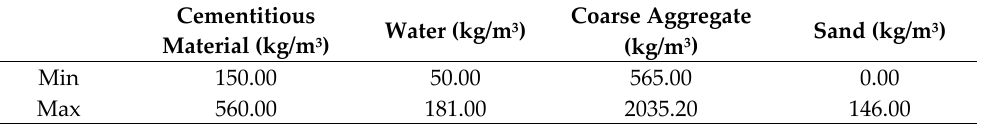
Table 2. PC components parameters found in